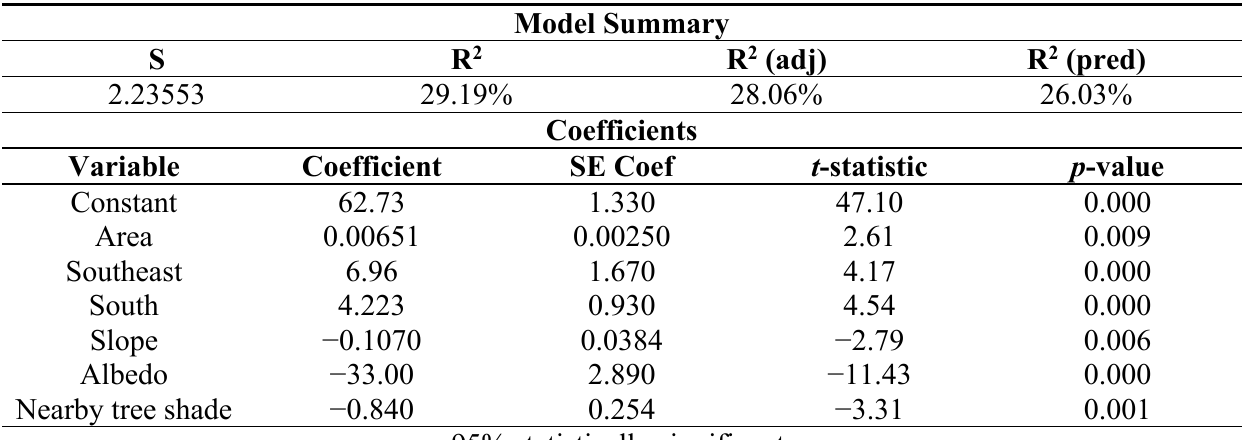
Table 8. Daytime regression analysis results by